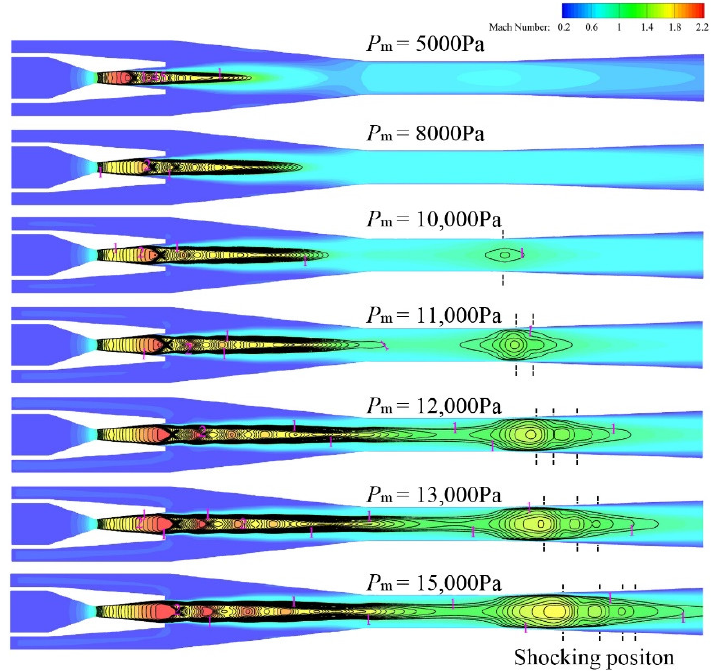
Figure 8. Ma counters with different P m .